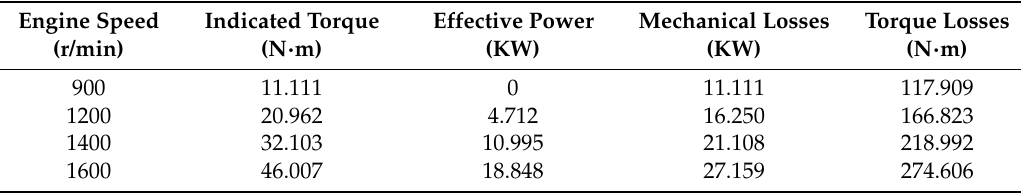
Table 2. Experimental data of the OP2S diesel